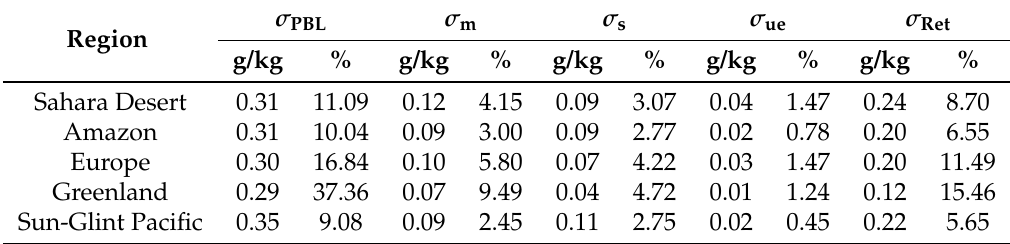
Table 2. Retrieval uncertainty components in g/kg and percentage of the retrieved PBL XH 2 O for 5 climatic regions. The a posterior uncertainties ( σ PBL ) are the far left-hand column of values, while the updated total retrieval uncertainties ( σ ret ) are contained in the far right-hand